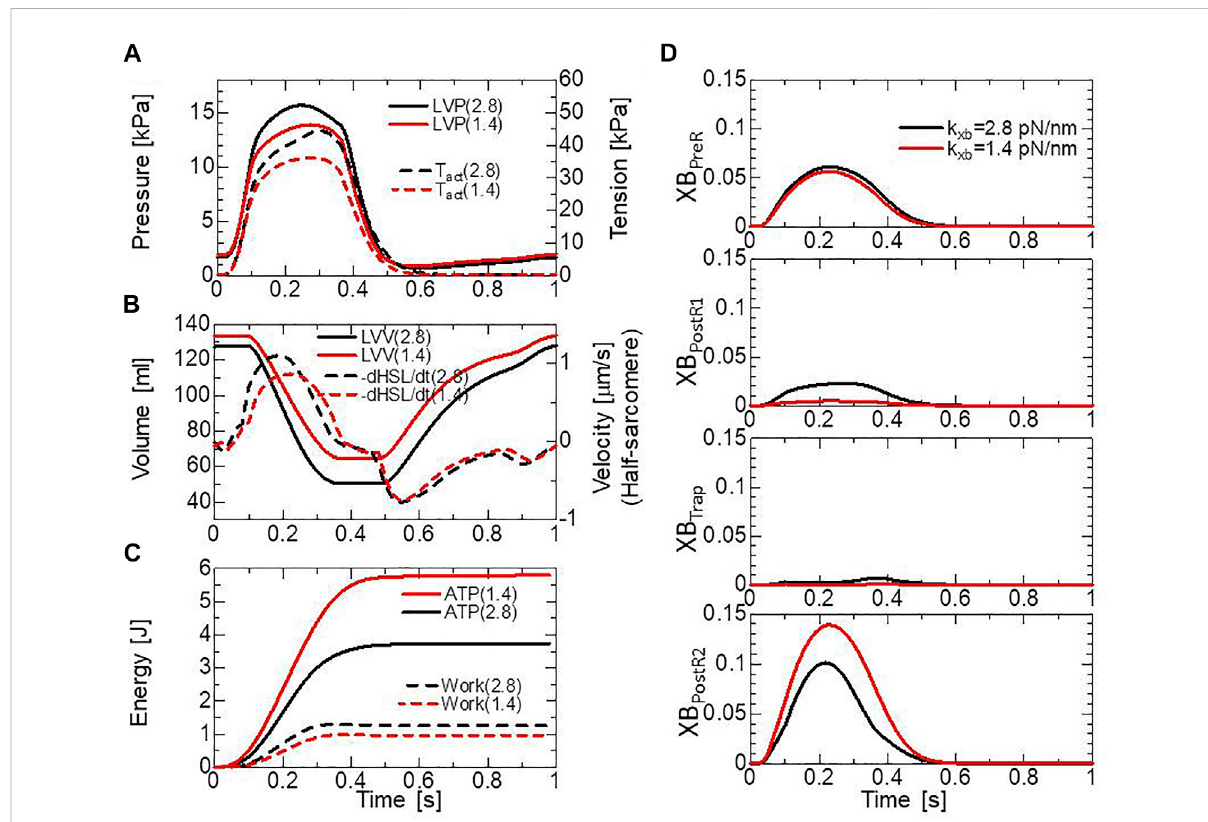
FIGURE 7 The comparison of pumping heart performance for different myosin rod distortion stiffnesses. The spring constants tested were k xb = 2.8 pN/ nm (black lines) and k xb = 1.4 pN/nm (red lines). (A) Time courses of the left ventricular pressure (solid lines) and the average active tension (broken lines) over the left ventricular wall (free wall and septum). (B) Time courses of the left ventricular volume (solid lines) and the average half-sarcomere shortening velocity over the left ventricular wall. (C) Time courses of cumulative energy consumptions (solid lines) and cumulative works (broken lines) by the active tension over the left ventricular wall. (D) Time courses of the population ratio of attached MHs in the left ventricular wall classi fi ed according to the attached